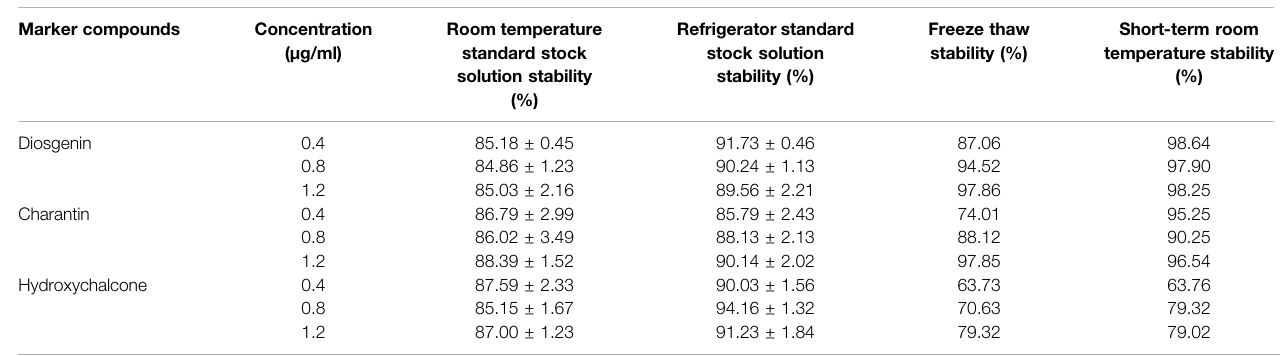
TABLE 7 | Stability data for diosgenin, charantin, and hydroxychalcone in rat plasma. Marker